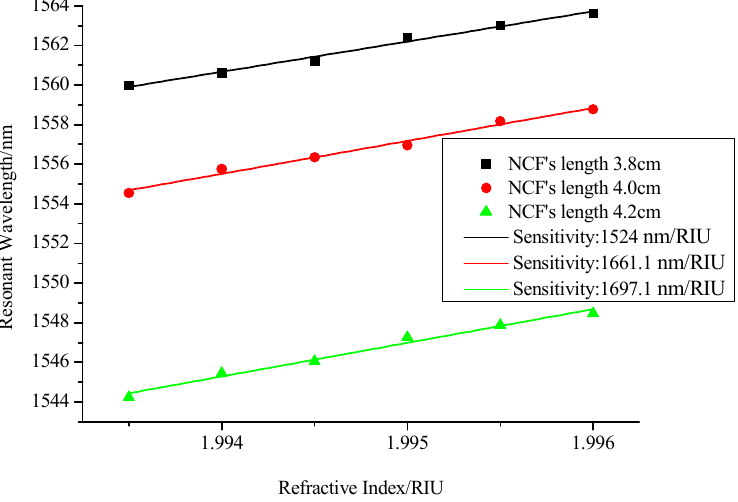
Figure 6. Relationship between resonant wavelength and refractive indices with different lengths of NCF.